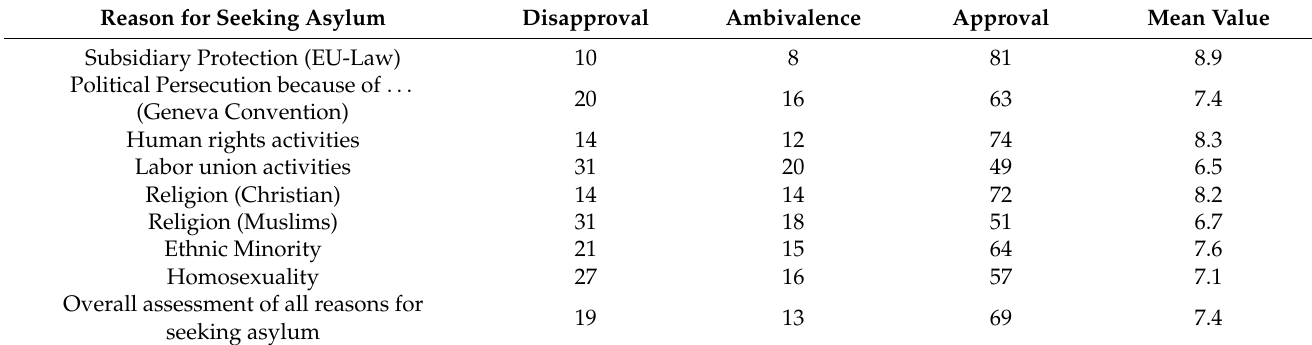
Table 2. Public opinion on the admission of different groups of refugees (%). Source from Jürgen Gerhards et al., German public opinion on admitting refugees , 25 May 2016, table made by authors.